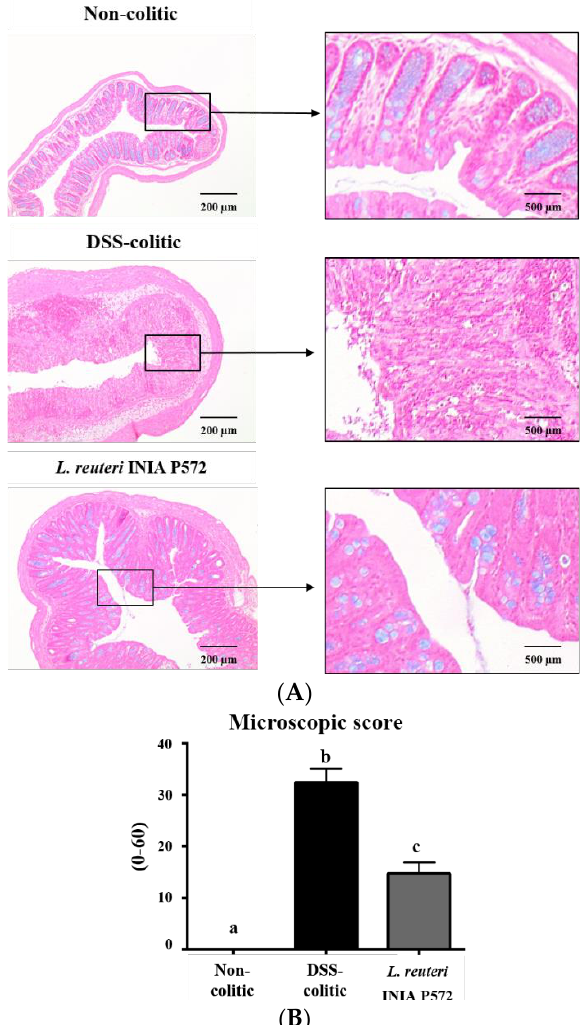
Figure 4. Impact of L. reuteri INIA P572 on ( A ) histological sections of colonic tissue stained with hematoxylin, eosin, and alcian blue. ( B ) Microscopic score assigned to each group according to the criteria previously described [50]. Data ( n = 10 per group) are expressed as mean ± SEM; groups with different letters statistically differ ( p <